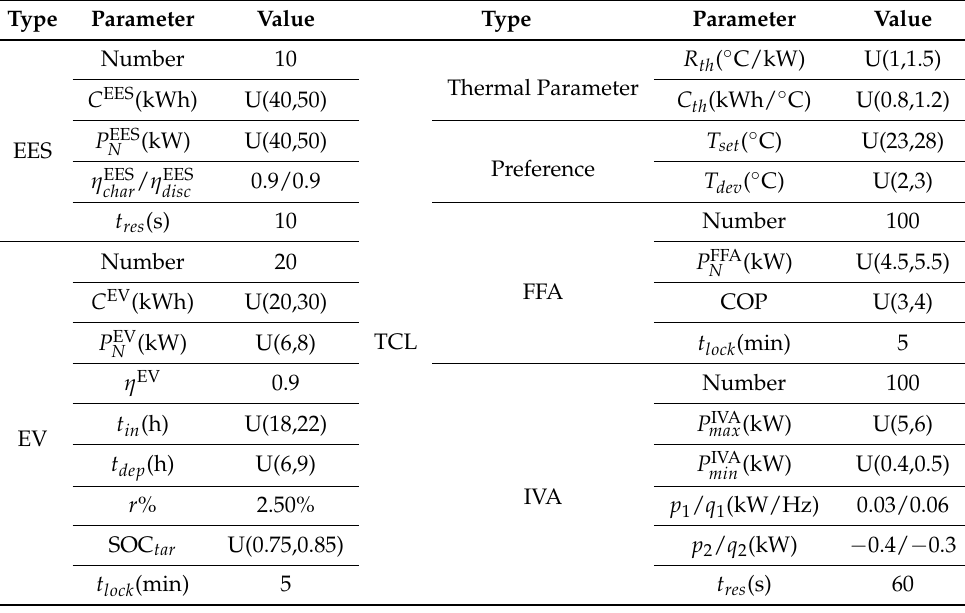
Table 1. Parameters of the GESs.